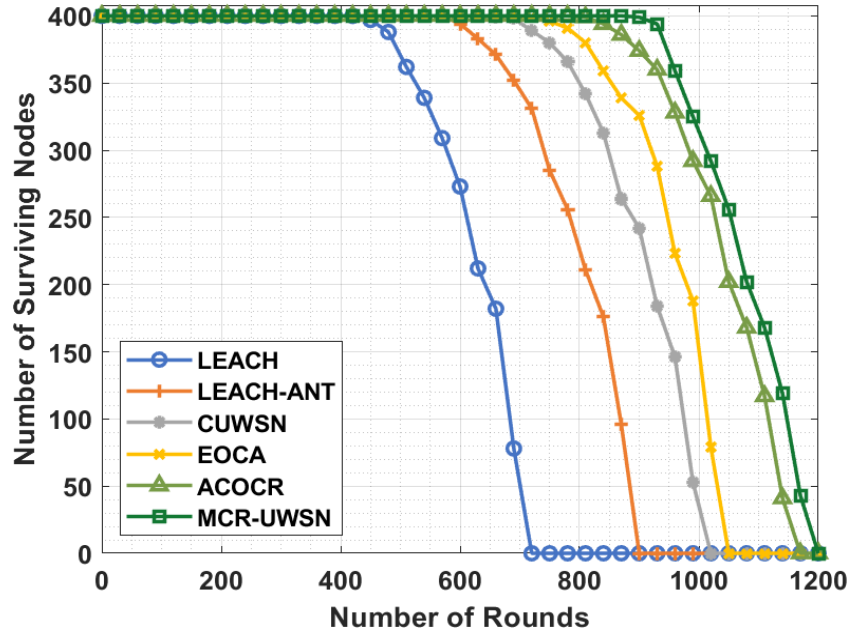
Figure 3. NSN analysis of MCR-UWSN method with existing approaches.